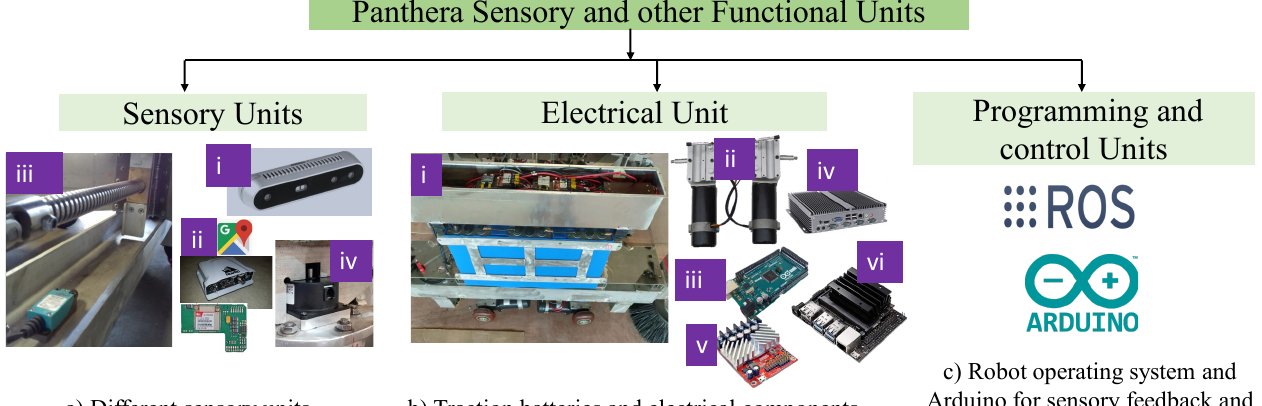
Figure 3. Sensory, electrical, programming and control units in